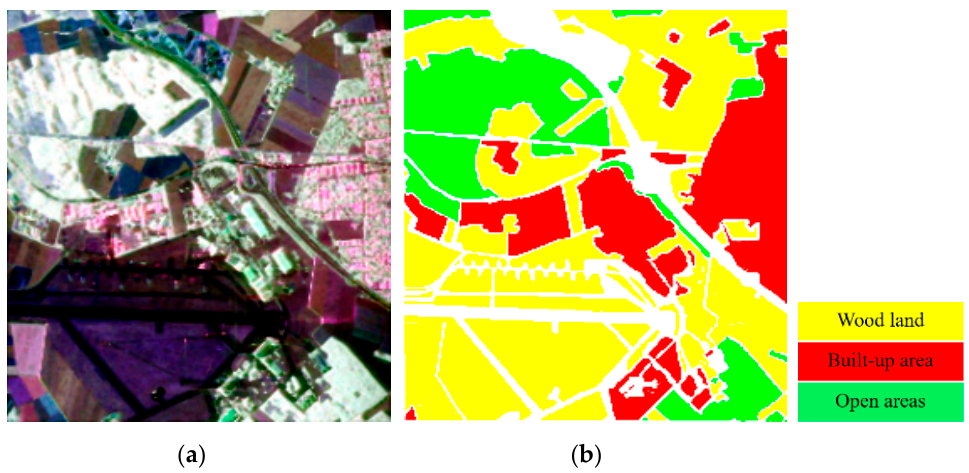
Figure 7. Original Oberpfaffenhofen dataset. ( a ) Pauli RGB image. ( b ) Ground truth and legend of ( a ).